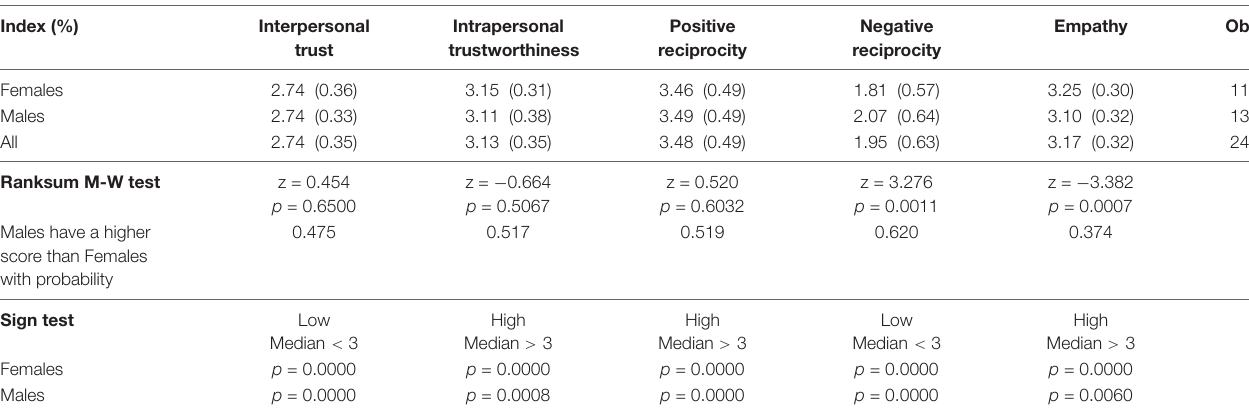
TABLE 5 | Summary of personality traits, by gender.